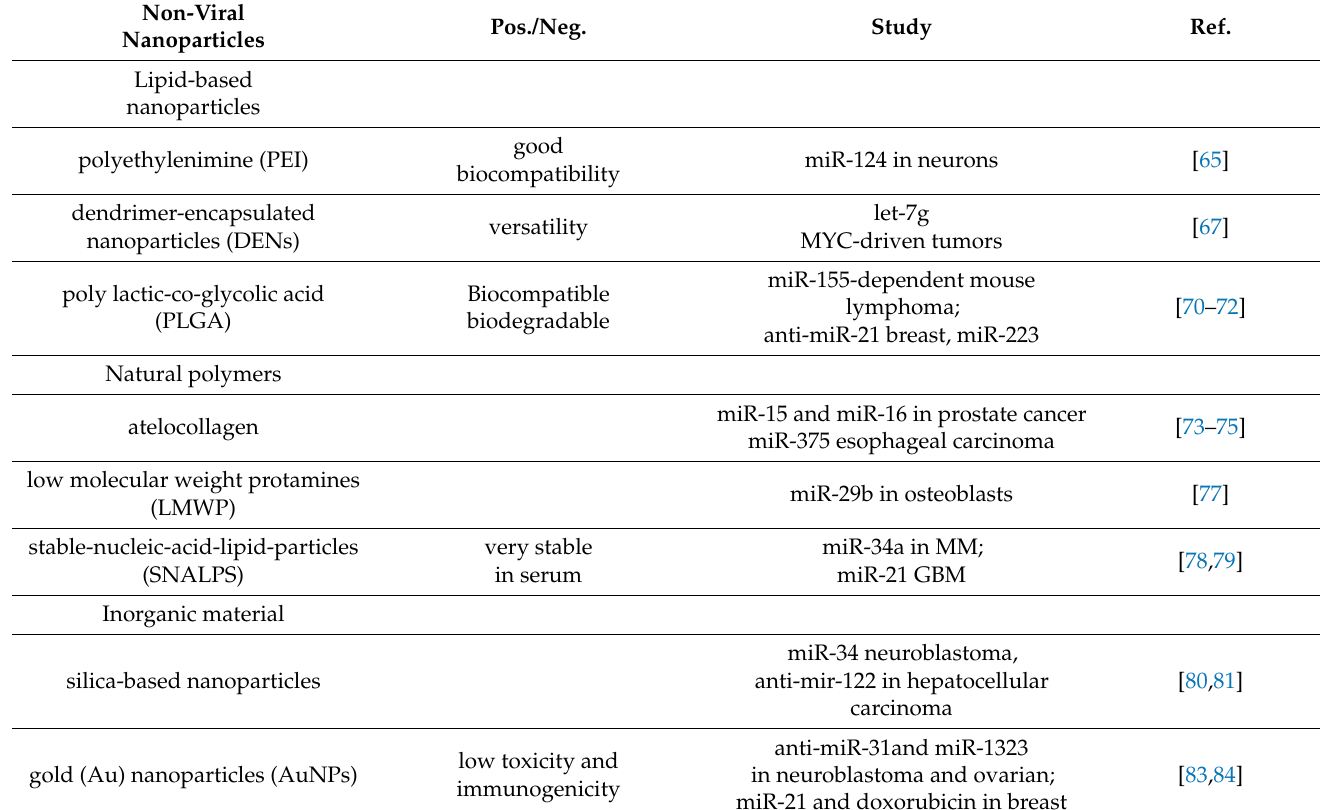
Table 2. Most employed non-viral